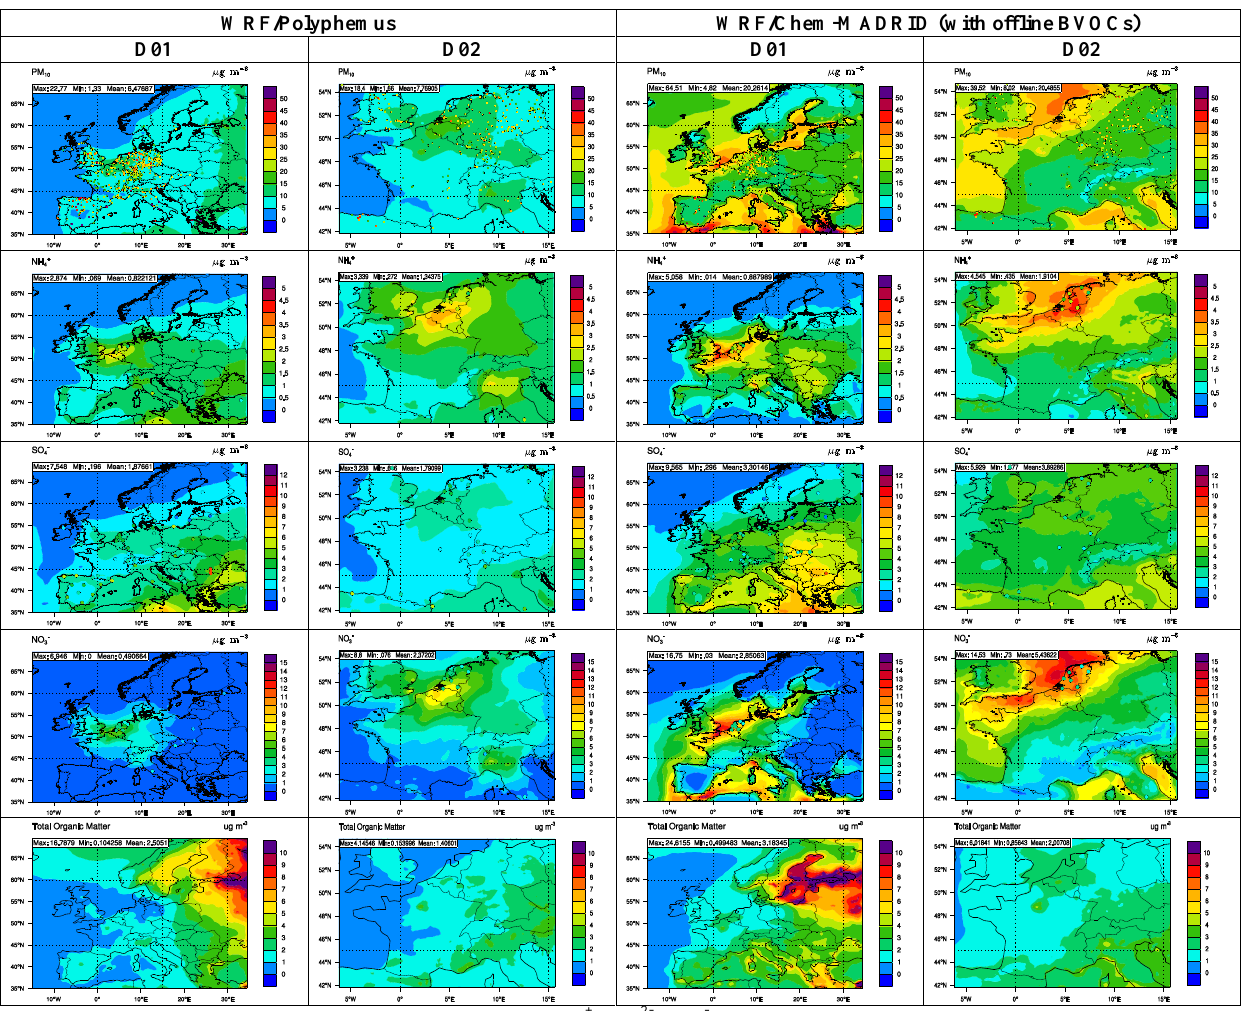
Figure 2. Simulated concentrations of PM 10 and its components, NH 4+ , SO 42- , NO 3- , and OM by WRF/Polyphemus and WRF/Chem-MADRID overlaid with observations in July 2001 over D01 and D02. No observations were available for OM.